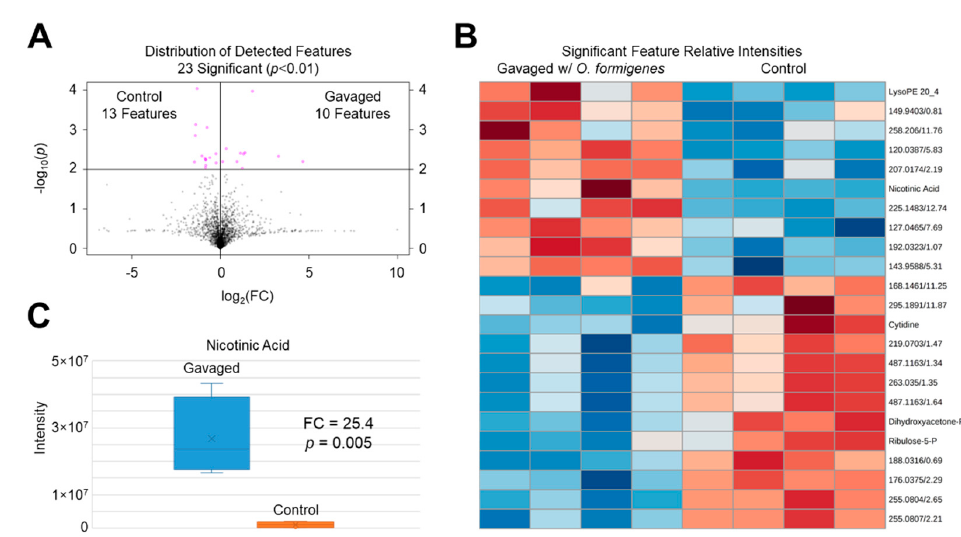
Figure 1. Oxalobacter formigenes oral gavage alters the mouse distal colonic mucosal metabolome. ( A ) Volcano plot showing detected features in the mouse distal colonic mucosa as a distribution of their statistical significance ( y -axis) and fold change ( x -axis). A total of 23 features were found to be significantly di ff erent ( p < 0.01) with 13 elevated in the non-gavaged control group and 10 elevated in the gavaged group. ( B ) Heatmap showing the top 25 significant metabolite features between C57Bl / 6 mice gavaged with 50 mg wet weight O. formigenes HC1 vs. non-gavaged mice (per group: n = 4; 2 males, 2 females). Data are Euclidean-distanced and Ward-clustered. Feature nomenclature: m / z / RT; “-P” indicates “Phosphate”. Red = elevated relative intensity, blue = reduced relative intensity. ( C ) Nicotinic acid is elevated (25.4-fold increase, p = 0.005) in the distal colonic mucosa of mice gavaged with O. formigenes relative to non-gavaged control